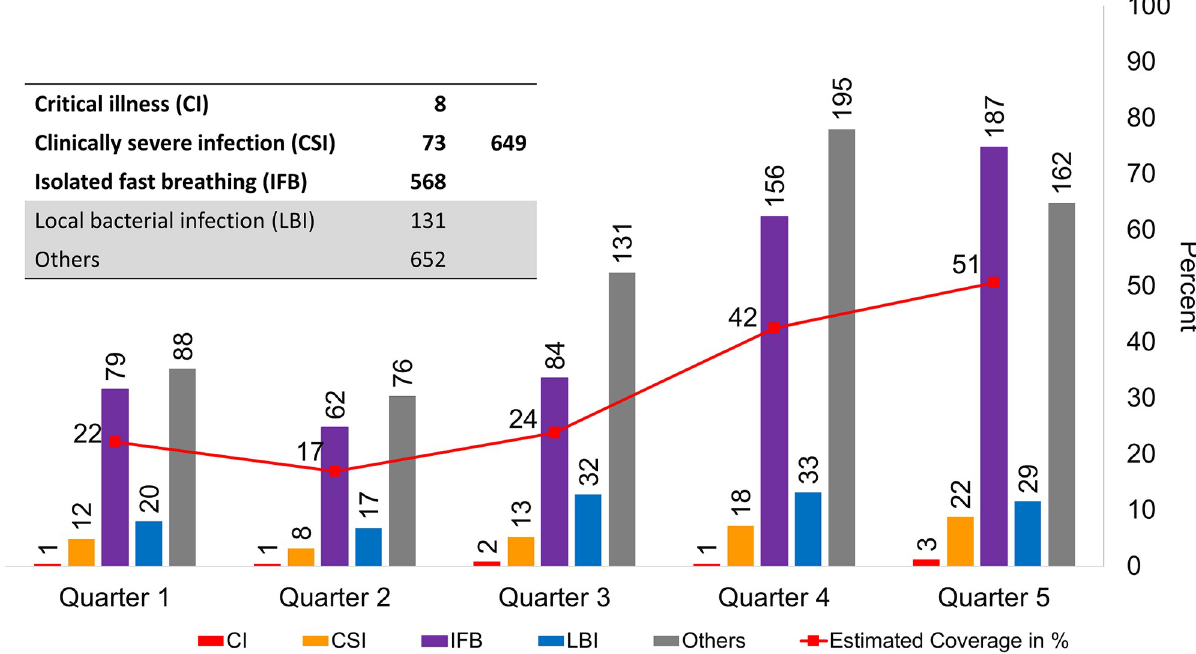
Fig 3. Number of sick young infants, including PSBI cases, receiving care from UH&FWC facilities and estimated coverage of expected PSBI cases (percent), from health facility registers, December 2015-February 2017 (N = 1432).